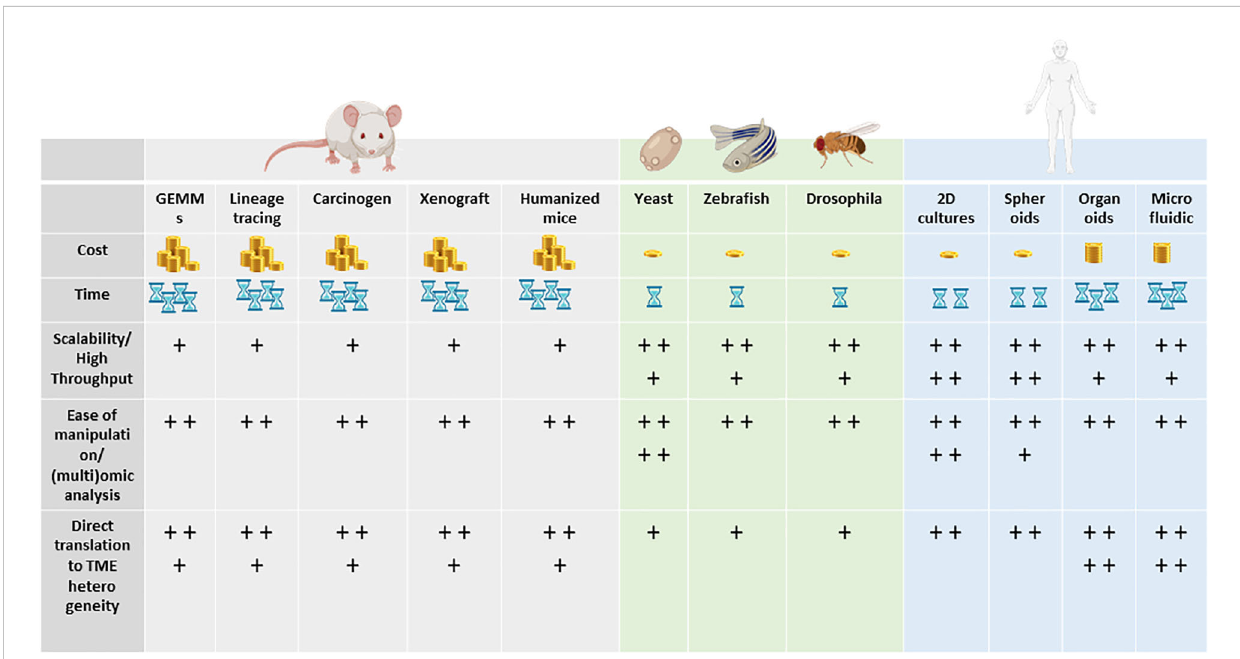
FIGURE 6 Key properties (cost, time, scalability, ease of manipulation, direct translation to TME heterogeneity) of the different models highlighted in this review. From left to right: murine models, non-murine models, and human models. + = low, ++ = medium, +++ = good / high, ++++ = excellent / very